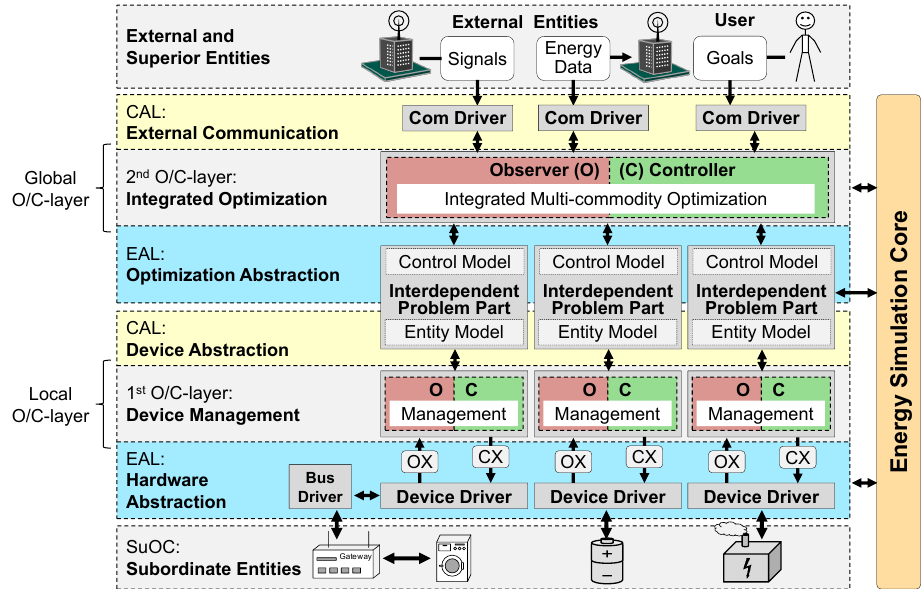
Figure 5.5: Architecture of the Organic Smart Home , partially based on